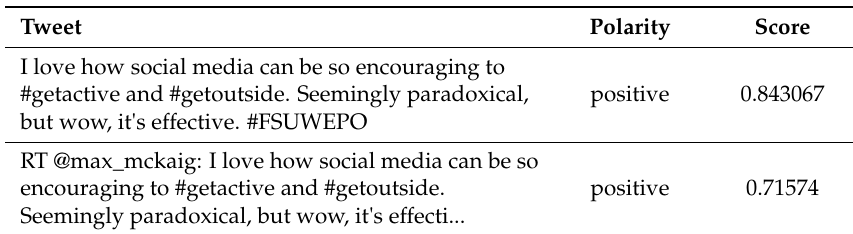
Table 3. Tweet vs. retweet polarity.